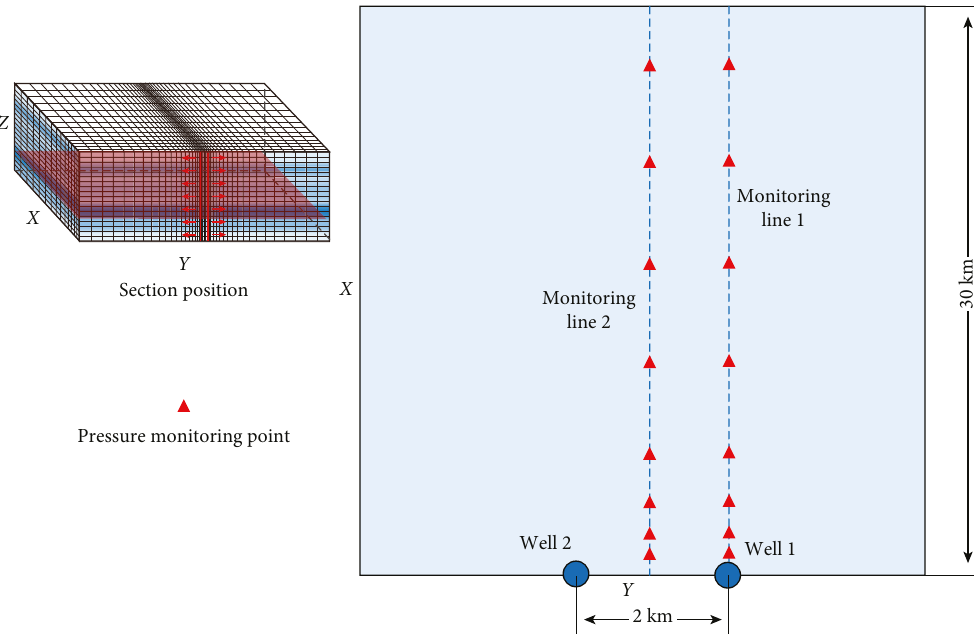
Figure 20: Positions of the pressure monitoring points in the 2-well model.